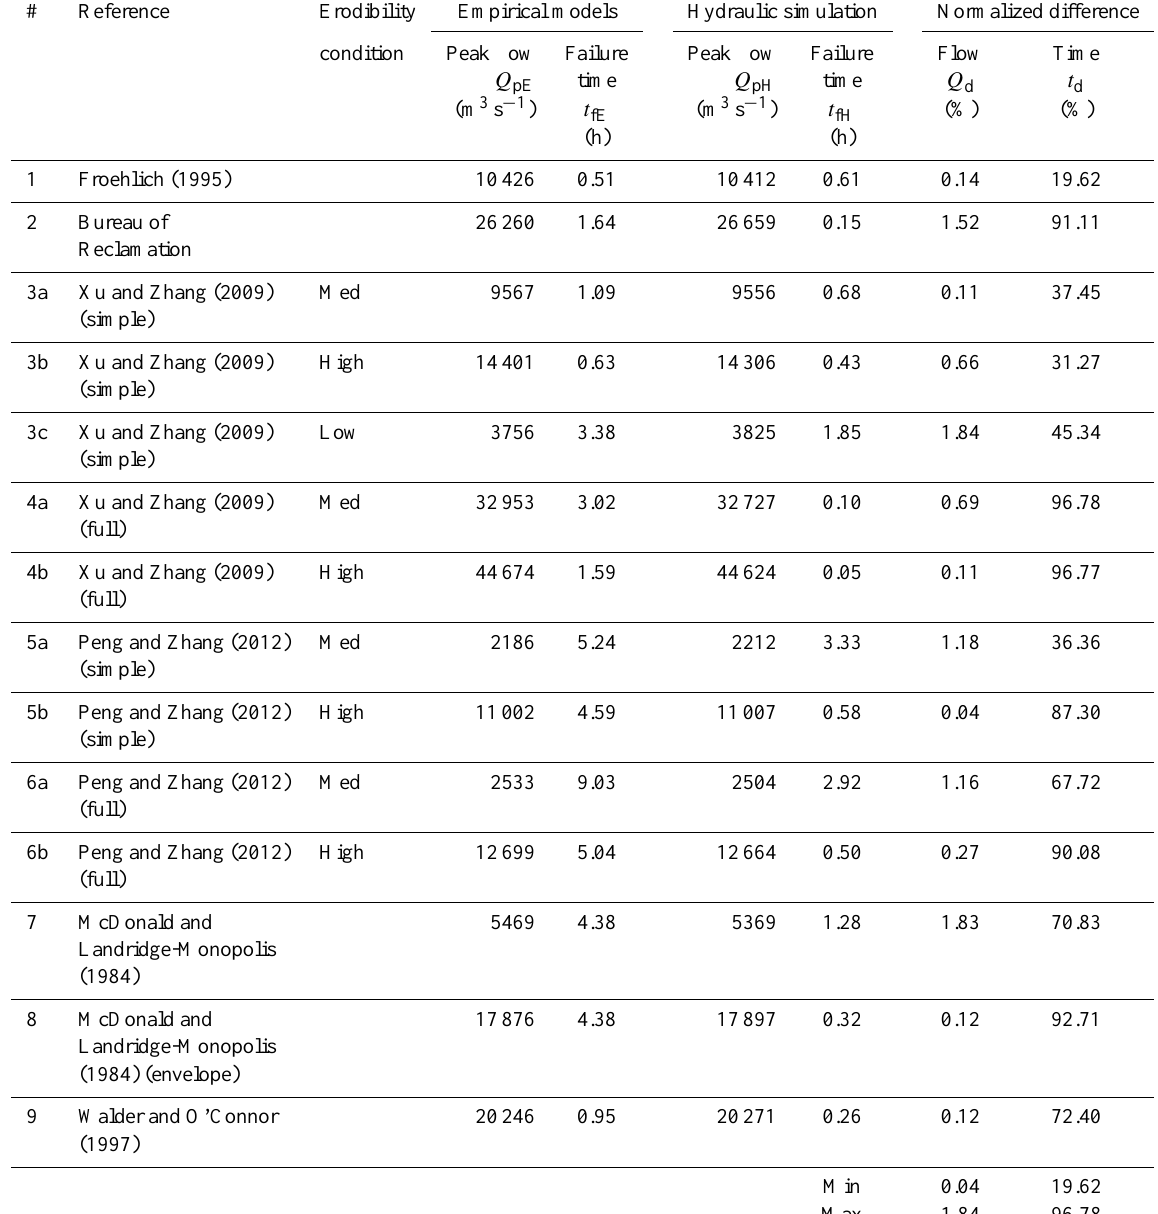
Table 4. Peak outflow (calibrated) and breach failure time (result) estimated by empirical models and hydraulic simulation for Lake Palca-